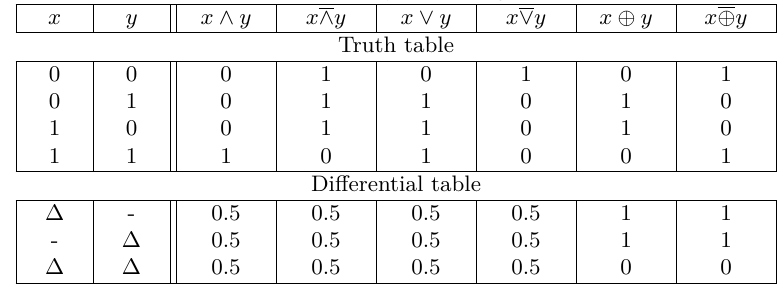
Table 3: Truth table and differential table of various binary operations. The entries in the differential table indicate the probability of having a